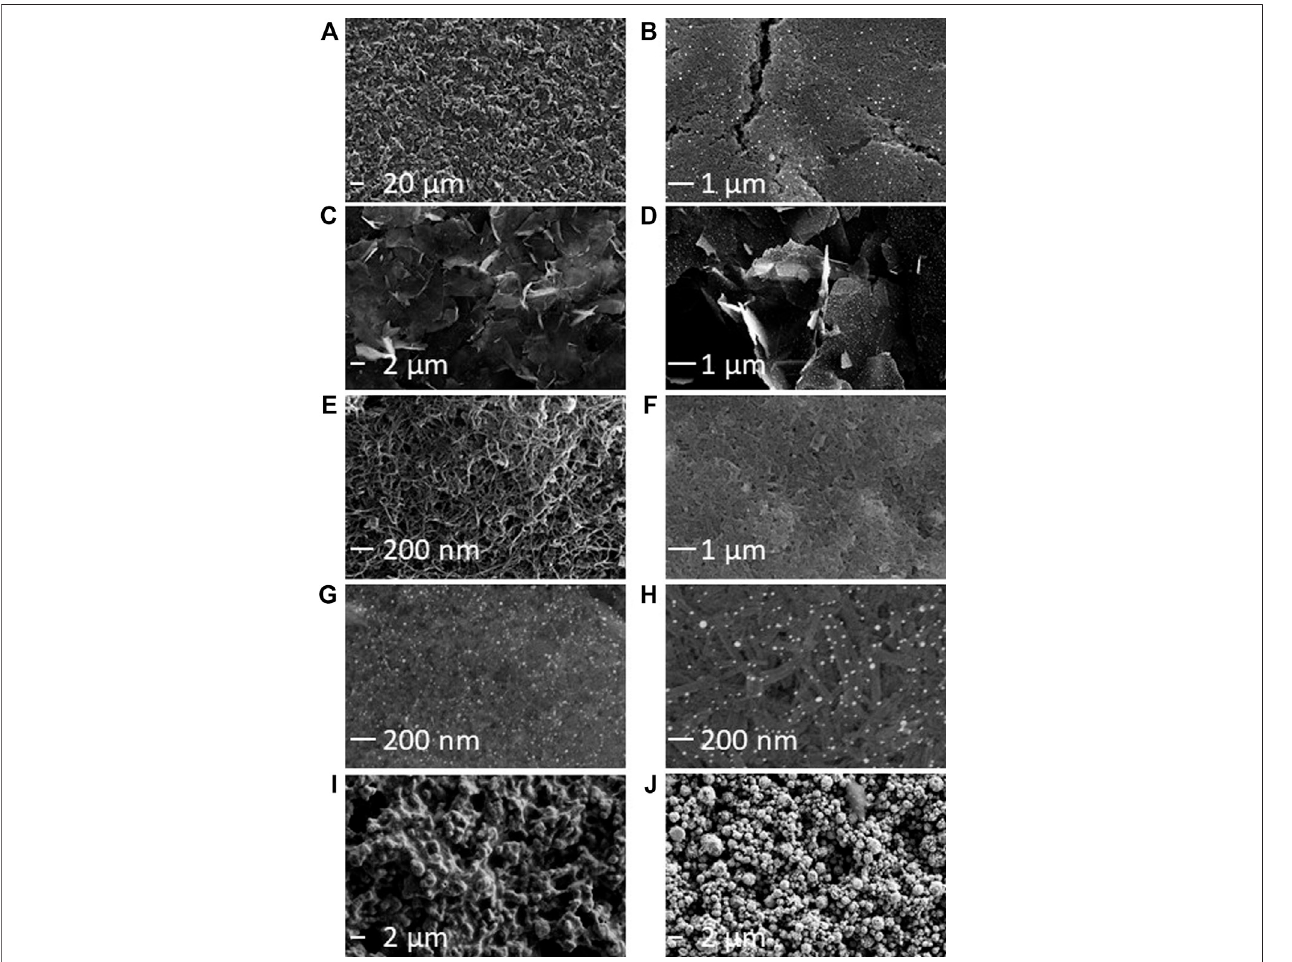
FIGURE1| SEMcharacterizationofcommerciallyavailableSPEvarieties. (A) Kanichi. (B) DS-GNP. (C) DS-GPH. (D) DS-GPH-GNP. (E) DS-CNT. (F) DS-CNF. (G) DS-CNT-GNP. (H) DS-CNF-GNP. (I) DS-Pt. (J) DS-Au. Additional SEM micrographs are included in Supplementary Figure S2 . An SE detector was used to collect micrographs A, I, and J. An in-lens detector was used for all other micrographs.